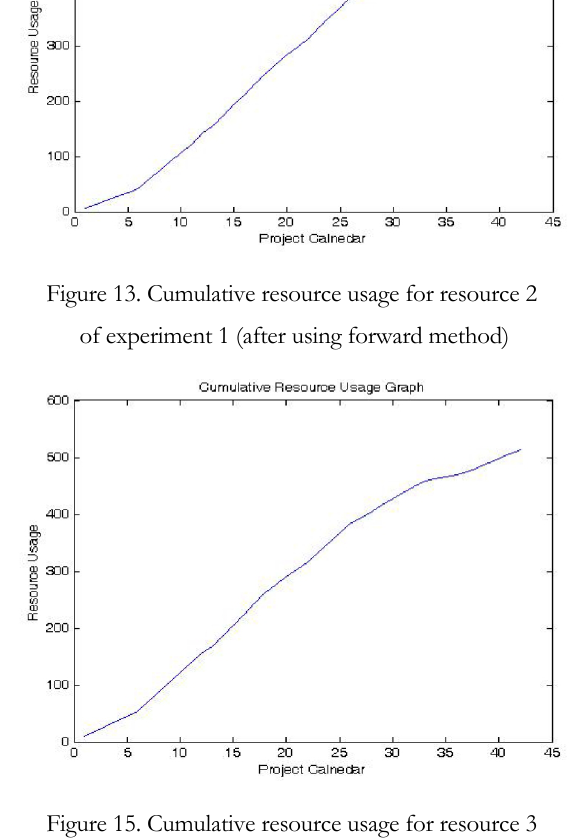
Figure 15. Cumulative resource usage for resource 3 of experiment 1 (after using forward